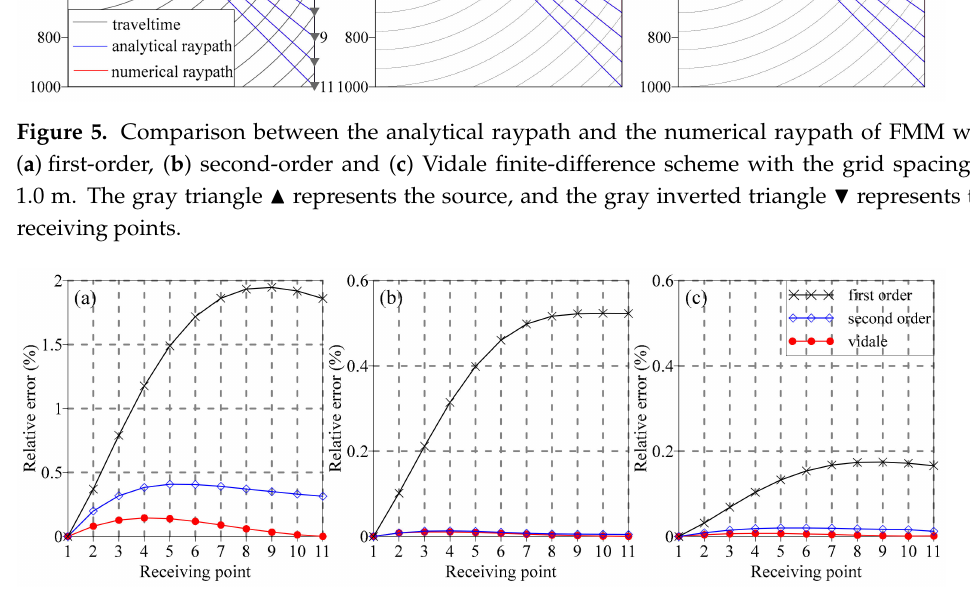
Figure 6. Relative error of FMM with different grid spacings of ( a ) 20 m, ( b ) 20 m with double-grid technology of 25 grid layers and 9 points of each grid and ( c ) 1.0 m. Table 1. CPU time of FMM with different finite-difference schemes and grid spacings. Finite-Difference